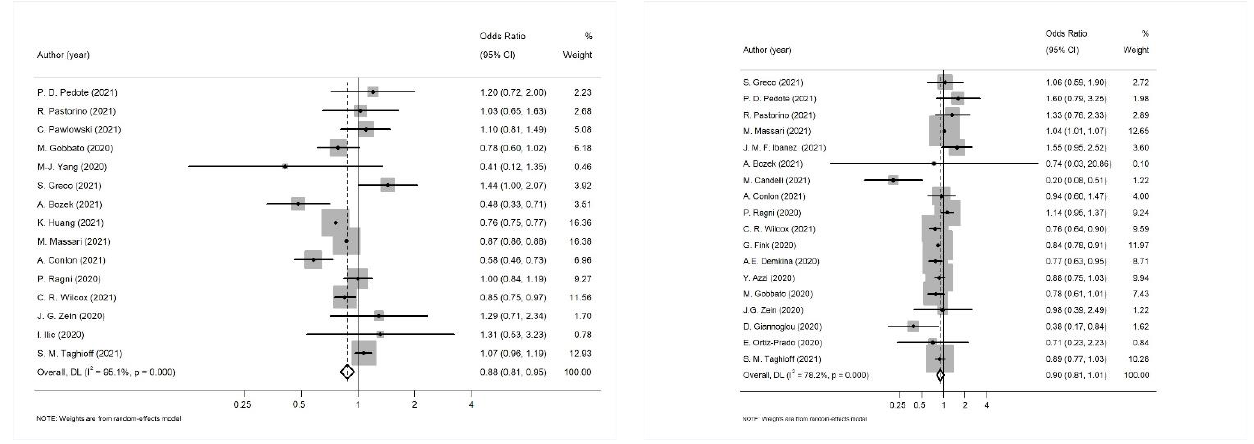
Figure 3. Left: Forest plot for the association between influenza vaccination and COVID-19 related hospitalization; Right: Forest plot for the association between influenza vaccination and mortality.